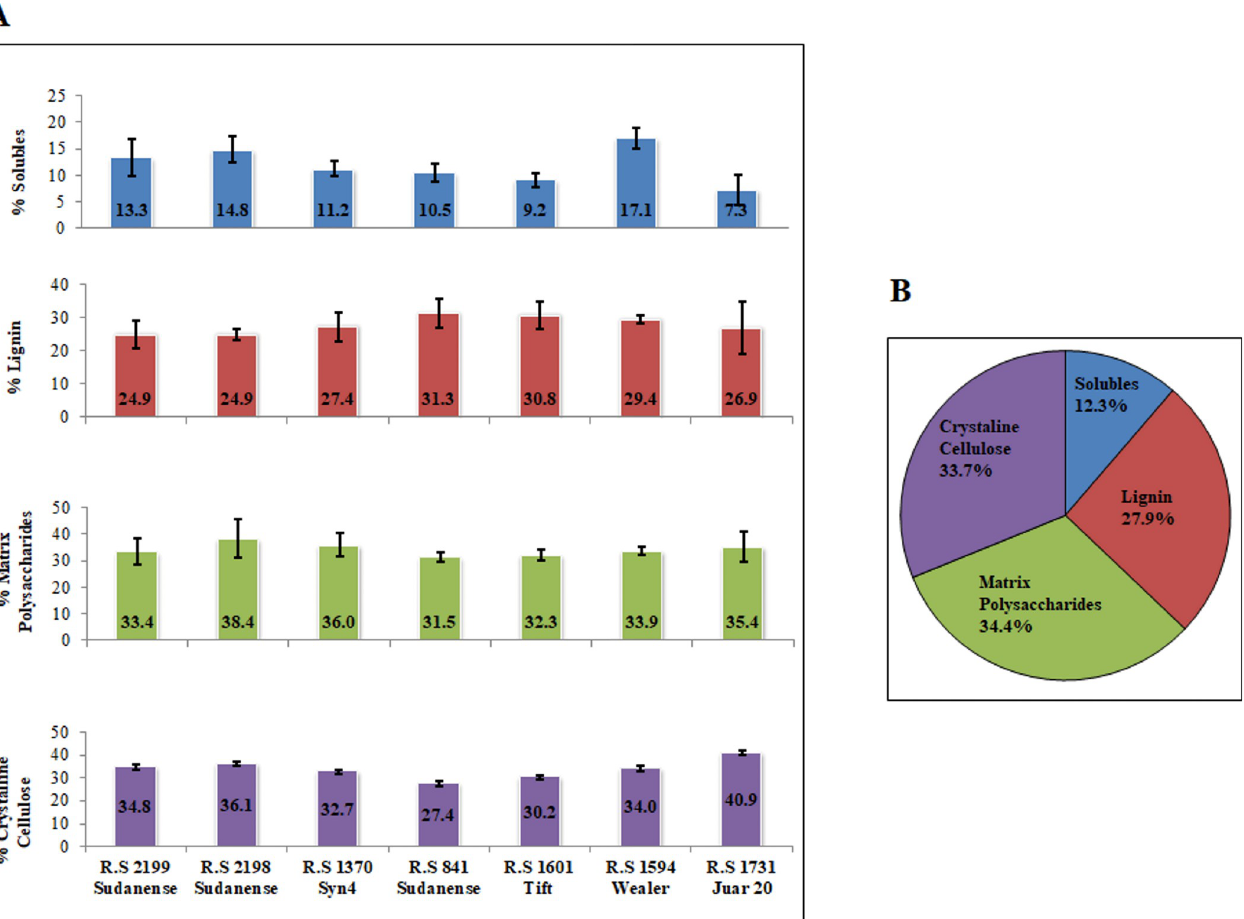
Fig 1. Major cell wall components in stems of sudangrass. (A) Major cell wall components by genotype. Vertical bars stand for standard deviation of the means. Note that soluble extractives show statistically significant differences across accessions (See S2 Table). (B) Average of major cell wall components.